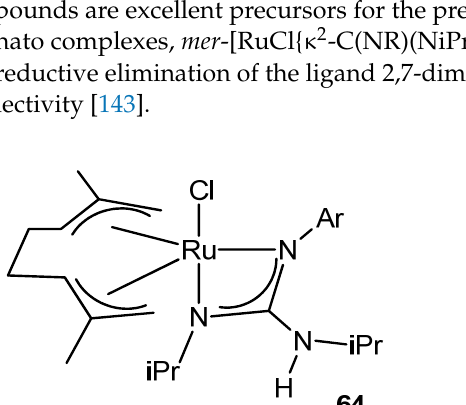
Figure 39. Osmium guanidinato complexes acting as aldoxime dehydration catalysts. Interestingly, in the search for new coordination modes, guanidines have been mod- ified with other donor groups, such as phosphanes. In this way, ruthenium (II) (Figure 40) and osmium (II) complexes were obtained [145,146]. Figure 40. Phosphane-modified guanidine as ligand in a ruthenium complex. This type of multidentate ligand allows the preparation of the iridium and rhodium guanidinato complexes as 68 , which behave as a frustrated Lewis pair (FLP) capable of reversibly activating polar bonds, such as those of water, and non-polar bonds, such as those of dihydrogen (Figure 41) [147,148].